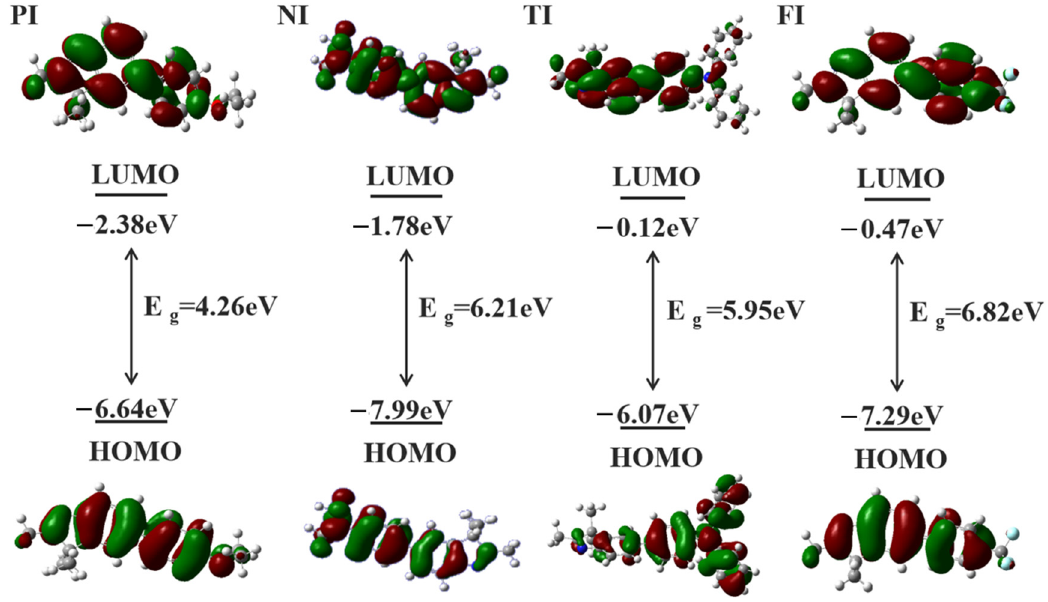
Figure 9. B3LYP/6-31G(d, p) calculated molecular orbital amplitude plots and energy levels of the HOMOs and LUMOs of PI , NI , TI and FI .